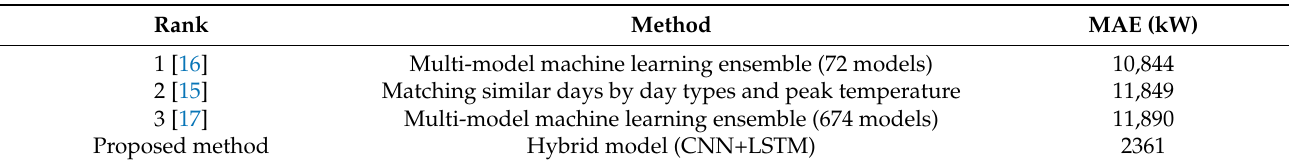
Table 4. Performance of the competition models and of the proposed